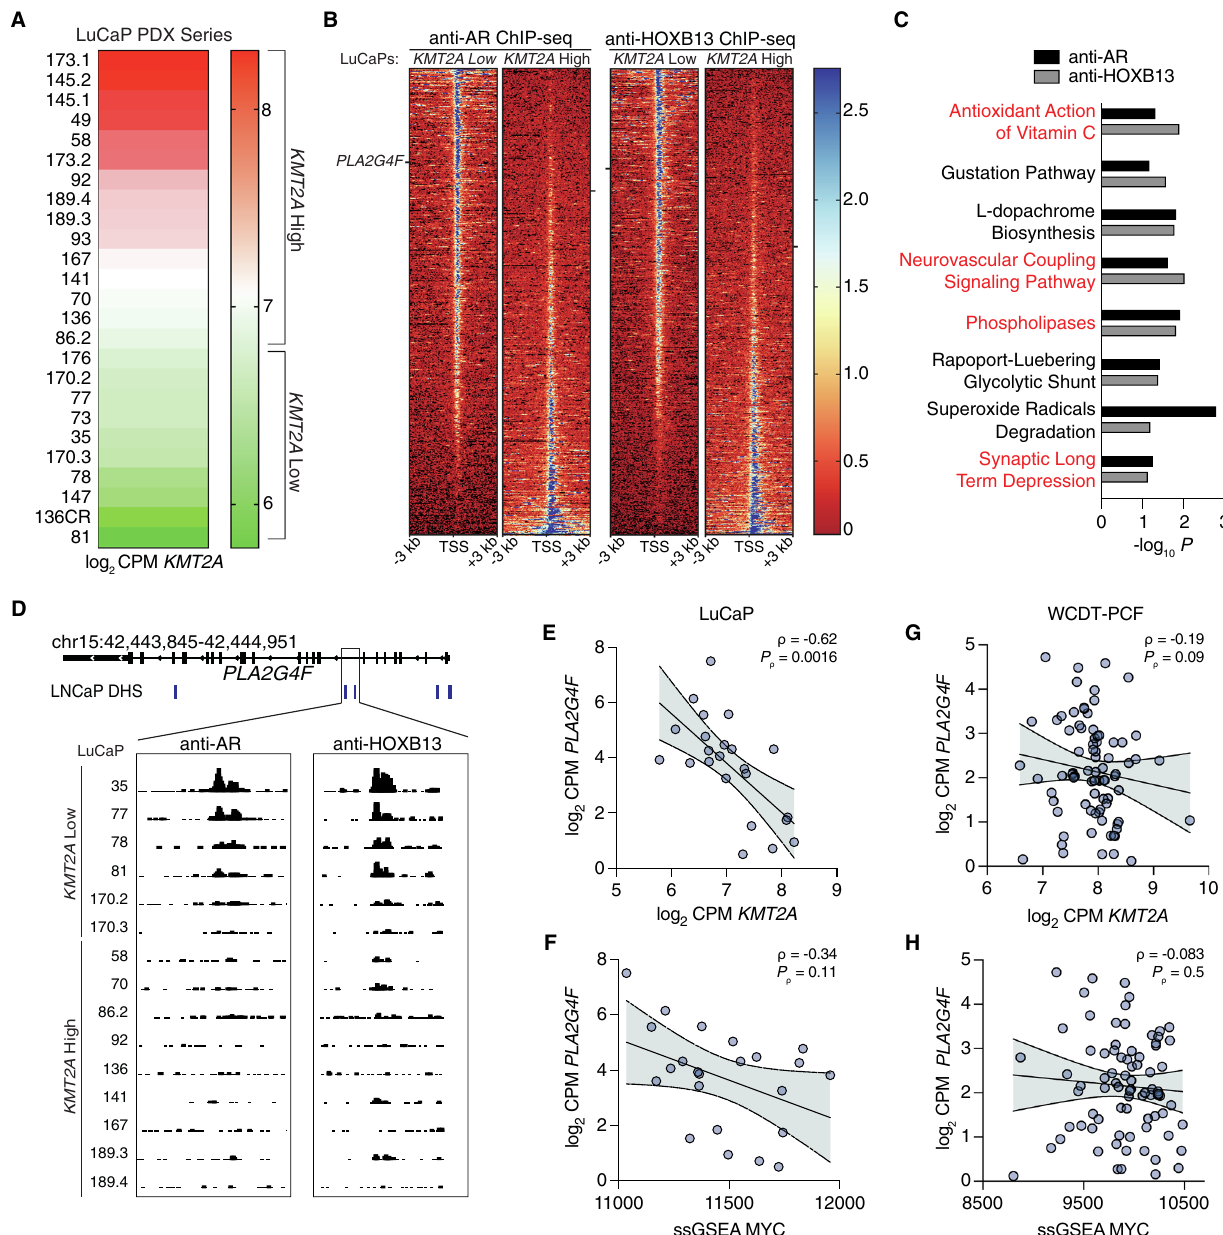
Fig. 4 Inverse relationship between PLA2G4F and KMT2A expression in metastatic prostate cancer. A Expression of KMT2A across the LuCaP PDX models in our study displayed as a heatmap, indicating which models are classified as KMT2A high or low. B Heatmap of anti-AR and anti-HOXB13 ChIP-seq [29] peak signals (aggregated across samples as indicated) around TSS regions (± 3 kb) in LuCaP PDX’s with differ- ential KMT2A expression. Each row is a peak ranked by KMT2A low to high. The location of PLA2G4F on heatmap is marked by a black bar. C Functional enrichment from Ingenuity Upstream Pathway Analysis of anti-AR and anti-HOXB13 ChIP-seq differential peaks overlapping genes for pathways with P < 0.1. Red indicates that PLA2G4F is present in the pathway gene set. D Integrative genome viewer tracks of the PLA2G4F gene locus from anti-AR and anti-HOXB13 ChIP-seq. LNCaP DNase-hypersensitivity regions shown in blue. E – H Spearman correla- tion of the log CPM expression level of PLA2G4F with log CPM expression level of KMT2A ( E , G ) or the 54-gene ssGSEA MYC activity score 2 2 ( F , H ) in the LuCaP ( E , F ) or the West Coast Dream Team-Prostate Cancer Foundation metastatic CRPC cohort ( G , H ). Samples with log CPM 2 PLA2G4F < 0 were excluded. The error bars represent the 95% confidence bands for linear